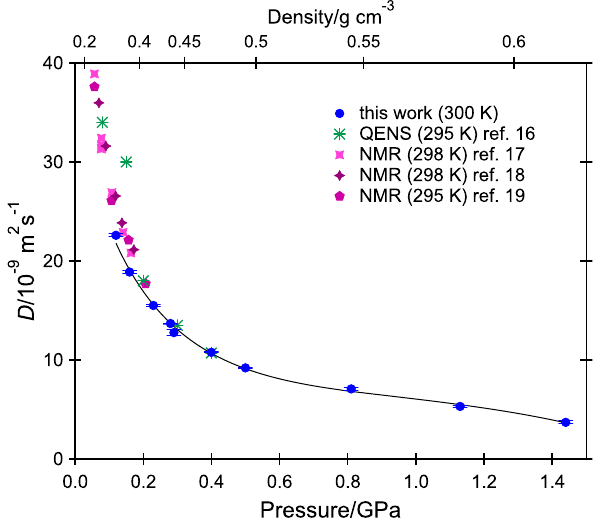
Fig. 3 Pressure dependence of the diffusion coef fi cient. Self-diffusion coef fi cient D of methane at 300 K as a function of pressure and its best fi t (solid line), reported in Eq. (2). Error bars correspond to one standard deviation, as obtained from the fi ts of ten data points shown in Fig. 2. Room-temperature literature values 16 – 19 above 0.05 GPa are also shown. The upper horizontal axis reports the density, as obtained from the equation of state of methane at 300